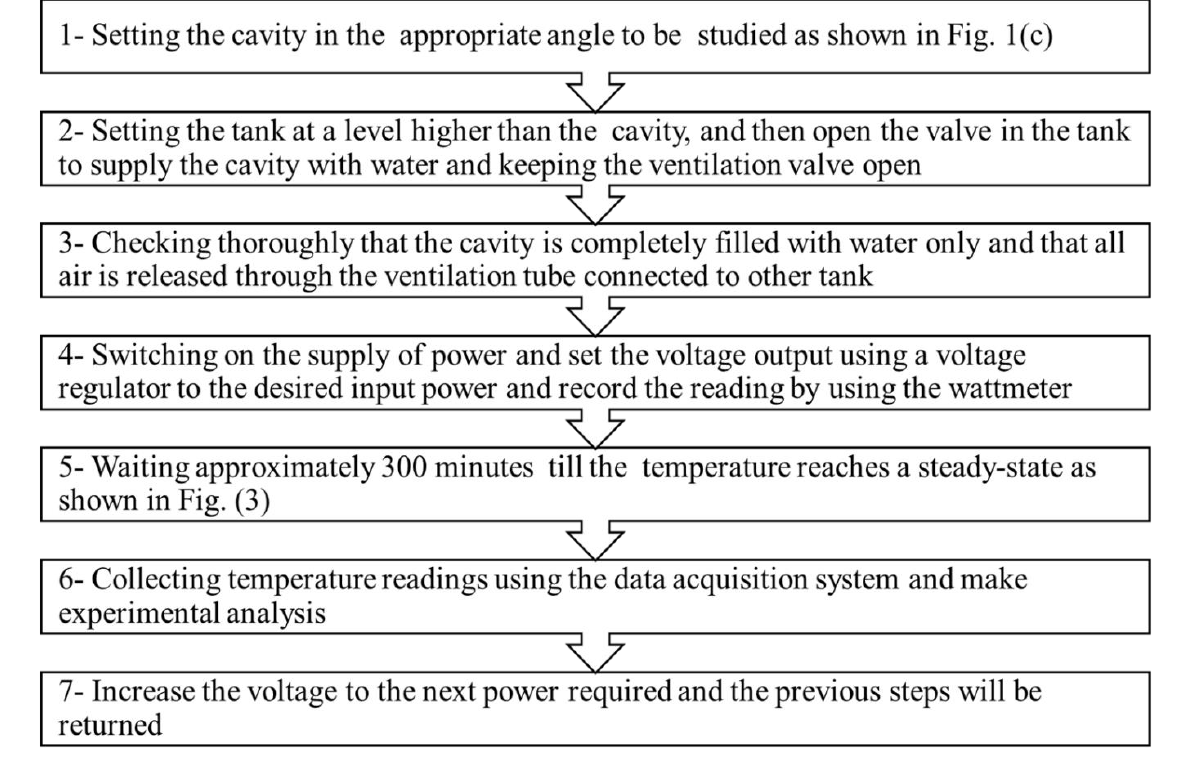
Figure 2. Experimental steps.